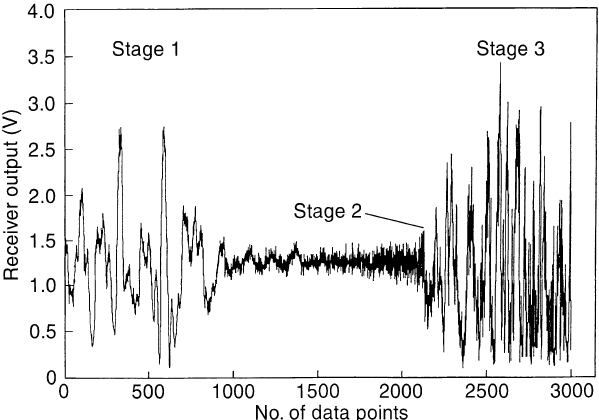
Fig. 1. Three different scintillation patterns are shown here. Stage 1 is associated with a discrete irregularity structure, stage 2 is a weak manifestation of quasiperiodic scintillation and stage 3 is the pattern of strong scintillations due to the well-developed plasma bubble. This